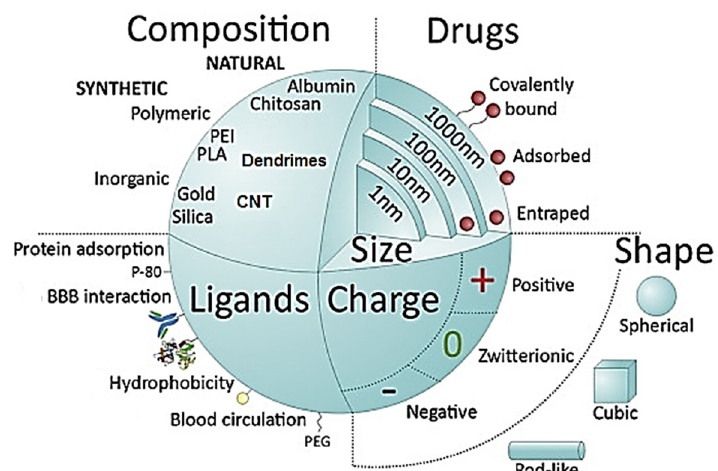
Figure 3. Key nanoparticle (NP) characteristics conditioning drug release and BBB crossing, classified in function of their composition (synthetic or natural), capacity for drug uploading, size, shape, charge, and possibility of surface functionalization to increase their biocompatibility and therapeutic efficacy. Reproduced from Ref. [53] with permission of the copyright holder.